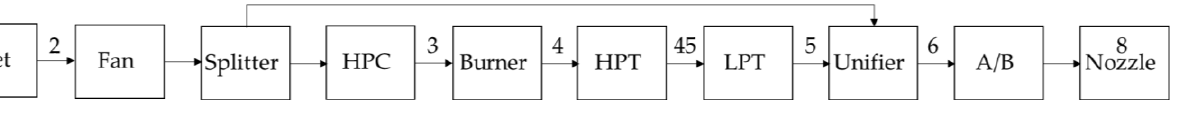
Figure 2. Schematic T-S diagram. Use of afterburner illustrated.